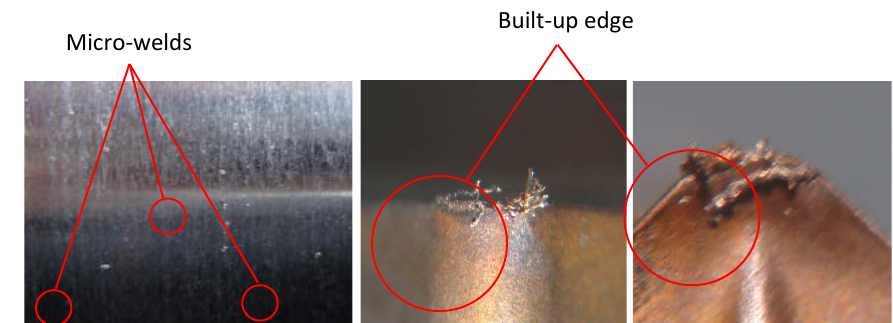
Fig. 11. Surface and contour plots for Ra